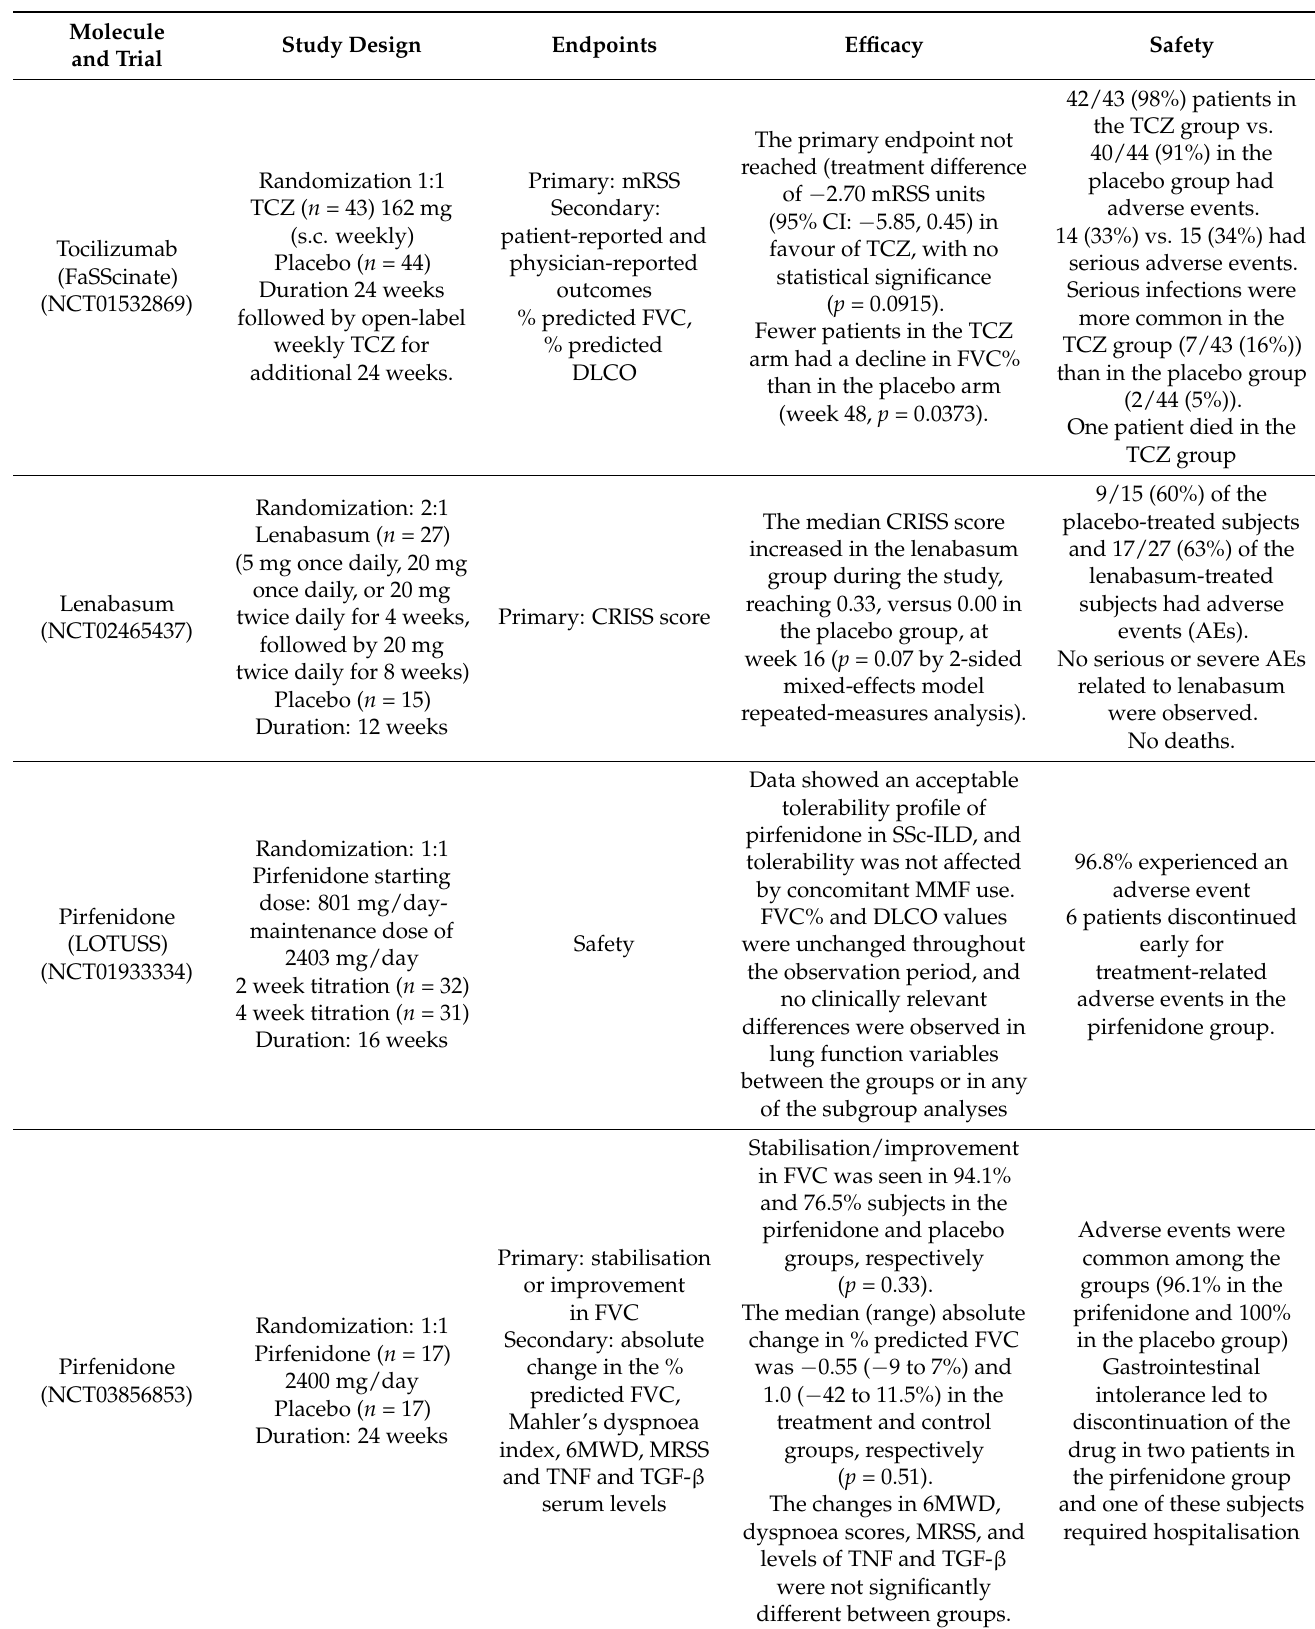
Table 1. Phase II randomized double-blind clinical trials in